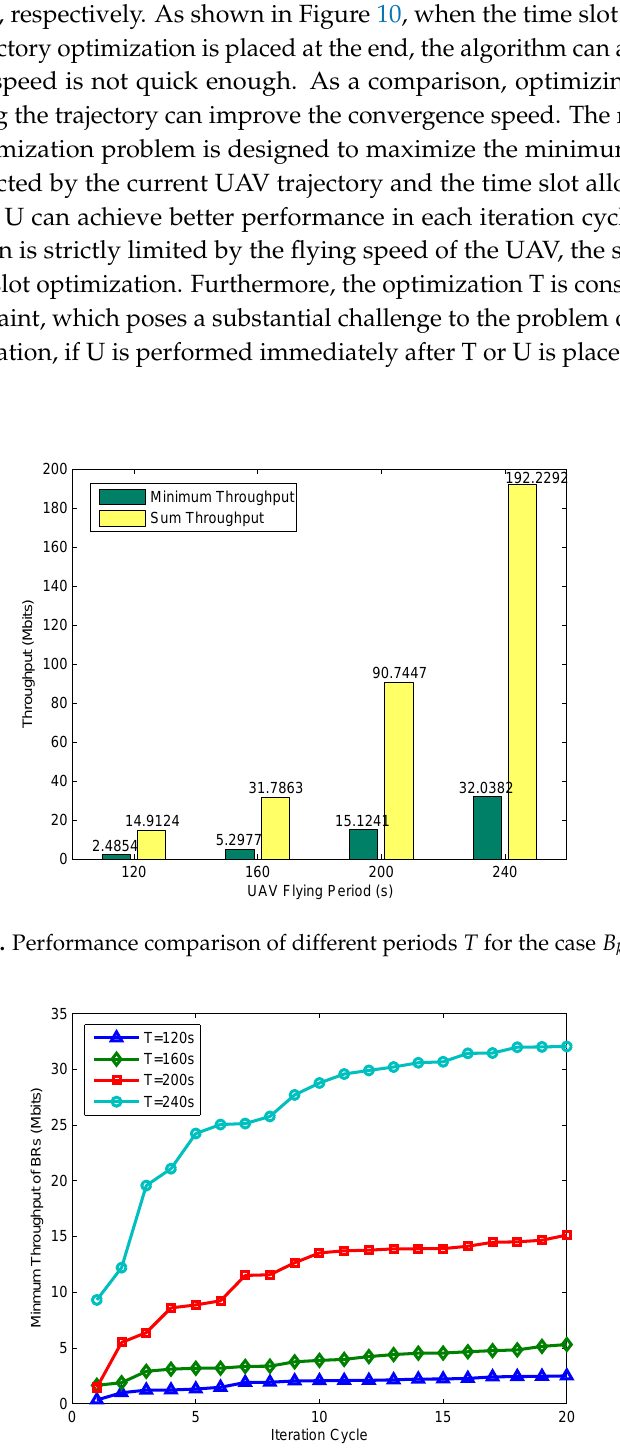
Figure 9. Convergence comparison of the BRs’ minimum throughput under different iterations for the case B k [ 0 ] >